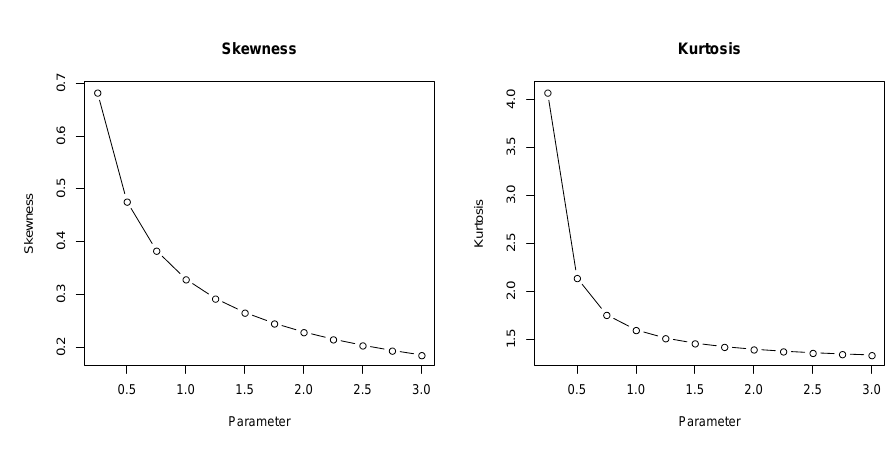
Figure 4 – Skewness and kurtosis for different values of θ